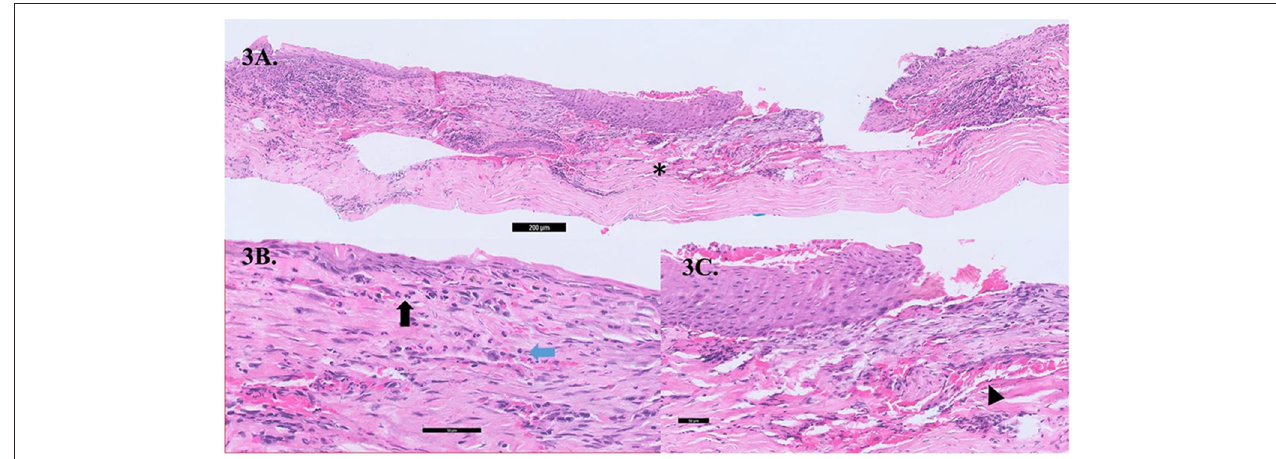
FIGURE 3 | (A) Cross-section gross histology slide showing significant stromal thinning (asterix,*) with overlying epithelial overgrowth. (B) The conjunctival stroma showing acute on chronic inflammation comprising of lymphocytes (blue arrow) and neutrophils (black arrow) within the stroma with an absence of malignant cells. (C) Neovascularisation (black arrow head) seen within the corneal stroma.